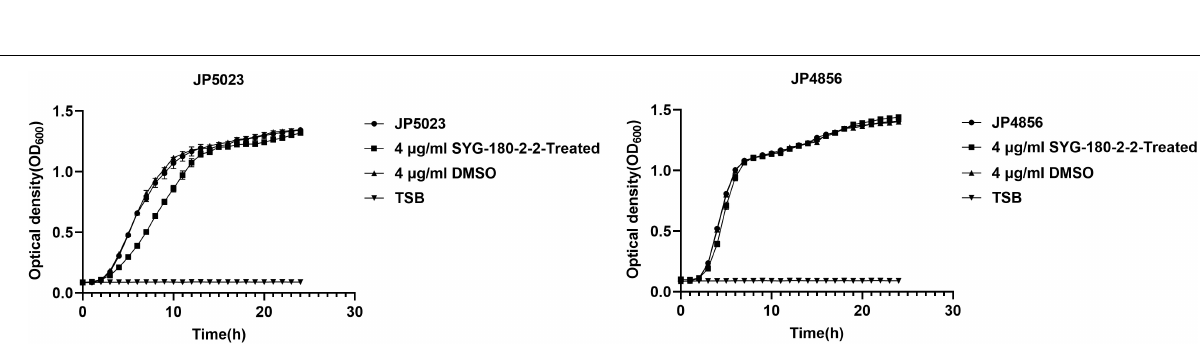
FIGURE 4 | Growth curves of methicillin-resistant Staphylococcus aureus (MRSA) strains treated with SYG-180-2-2. Strains JP5023 and JP4856 were cultured with 4 µ g/ml of or without SYG-180-2-2. Trypticase soy broth (TSB) was used as a blank control. Dimethyl sulfoxide (DMSO) was used as a control in order to exclude the influence of solvent on bacterial